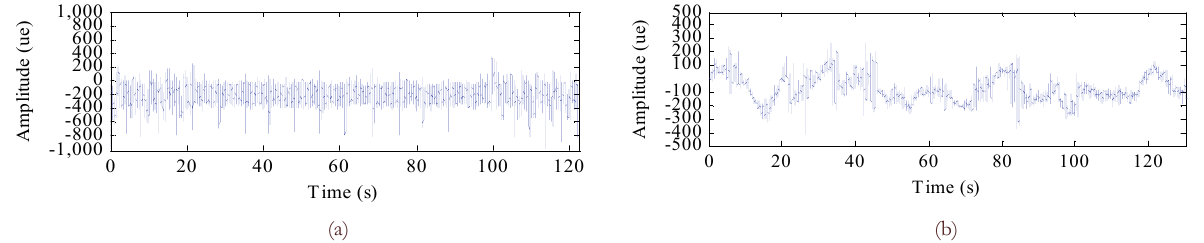
Figure 1: The strain signals used for the work: (a) SAESUS, (b) An experimental measured data,